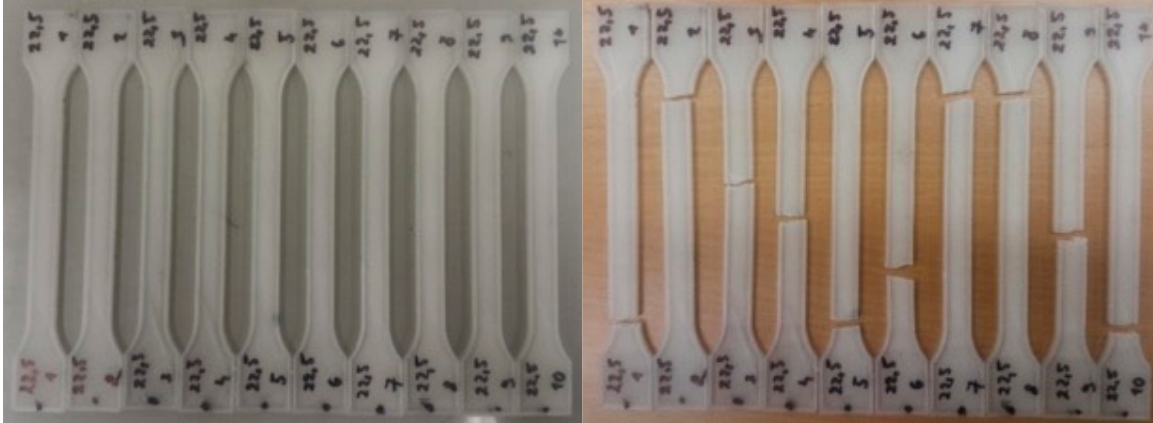
Figure 14. Set of samples (orientation 22.5°) before and after the test.